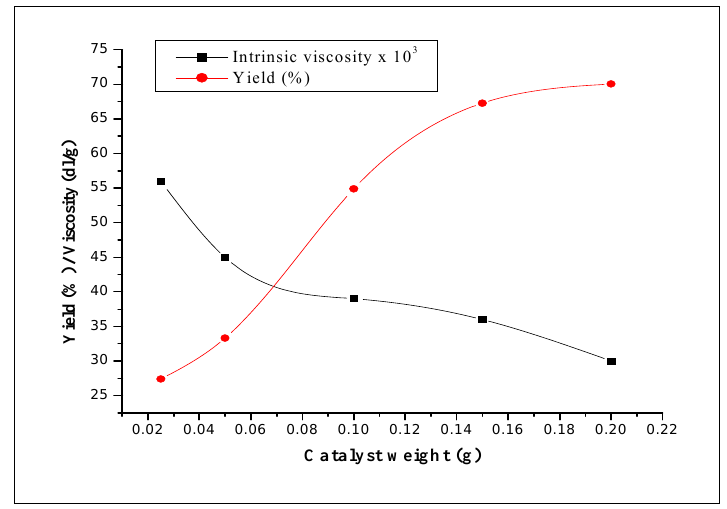
of poly(THF). Reaction m